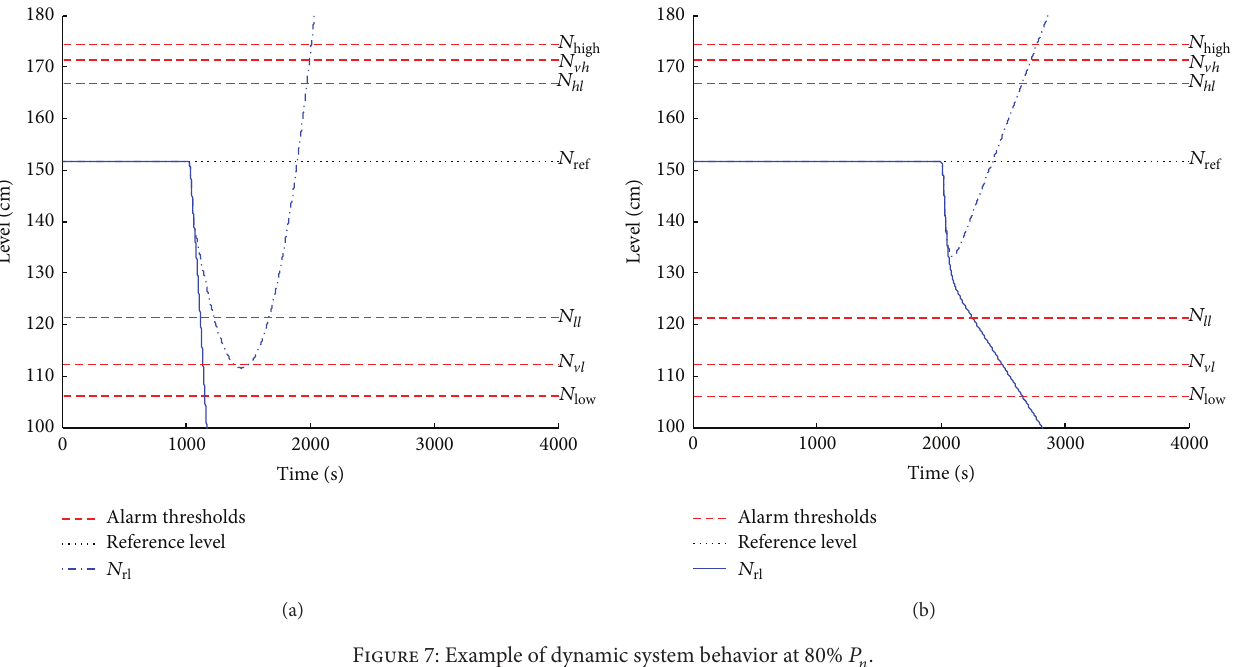
Figure 7: Example of dynamic system behavior at 80% 𝑃 𝑛 .